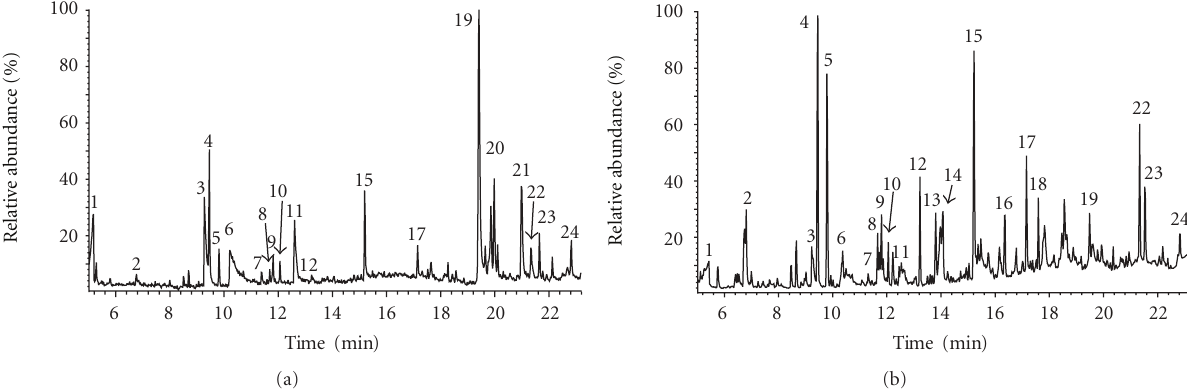
Figure 3: Chromatogram of the products formed during pyrolysis of (a) melanin isolated from the human melanoma malignum (A-375 cell line) treated by DMSO, and (b) model synthetic eumelanin (Tyr-melanin). Peak designation: (1) acetic acid, (2) benzene, (3) pyridine, (4) pyrrole, (5) toluene, (6) acetamide, (7) pyridine, 2-methyl-, (8) furfural, (9) pyrrole, 2-methyl-, (10) pyrrole, 3-methyl-, (11) pyridine, 4-methyl-, (12) styrene, (13) furanone, (14) cyclohexanone, (15) phenol, (16) n.i., (17) phenol, 2-methyl-, (18) phenol, 4-methyl-, (19) 1,2-benzenediol, (20) n.i., (21) 1,2-benzenediol, 4-methyl-, (22) indole, (23) 2-methoxy-4-vinylphenol, (24) indole,